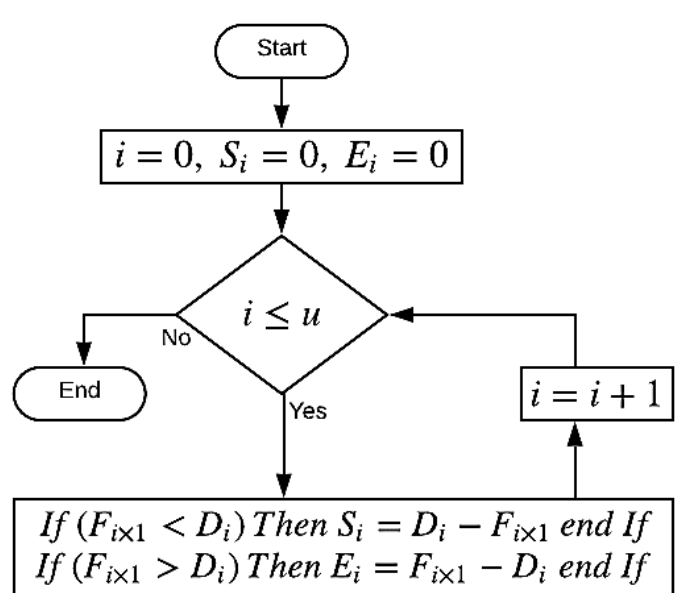
Figure 1. Shortages and surpluses algorithm.